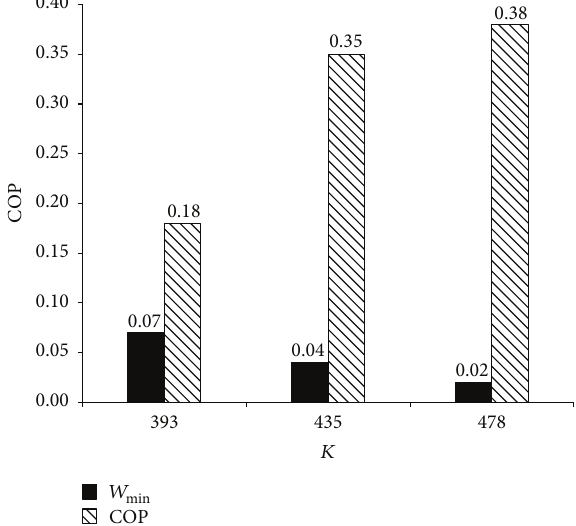
Figure 8: Effect of desorption temperature on 𝑊 min and COP.